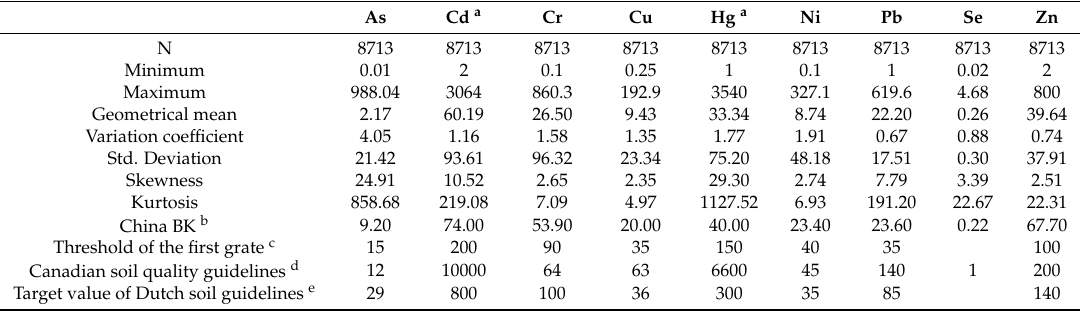
Table 1. Statistics of studied elements (mg · kg − 1 ) in soils (0–20 cm) of Hainan Island. As Cd